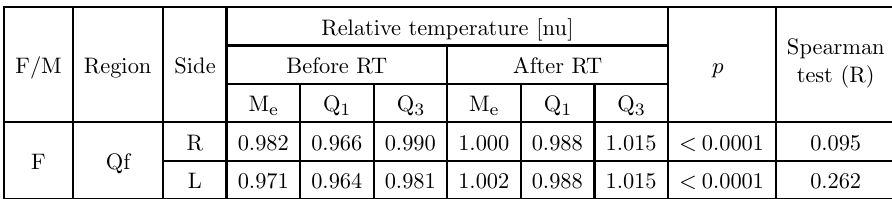
Spearman test (R)F/M Region